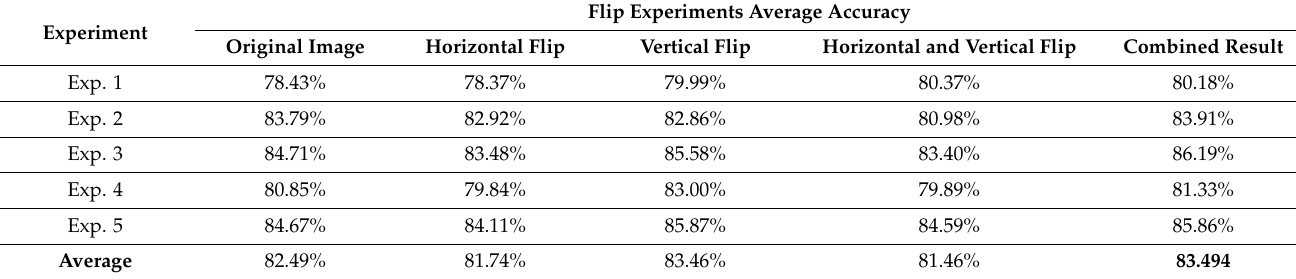
Table 4. Average accuracy for flip experiments.